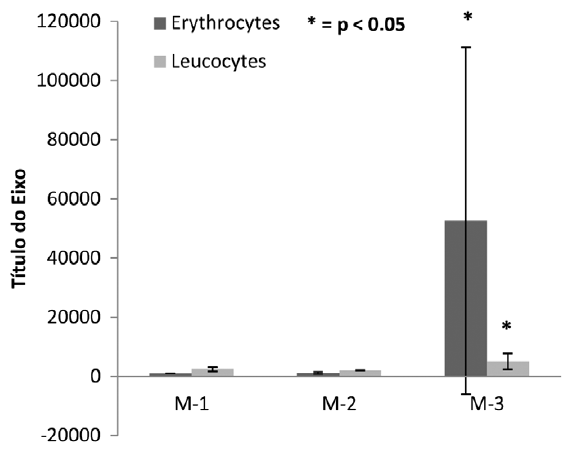
Figure 3 - Erythrocytes and leucocytes count in units/mL in the beginning of training season (M-1), before the competition (M-2) and after the competition (M-3), * = p <